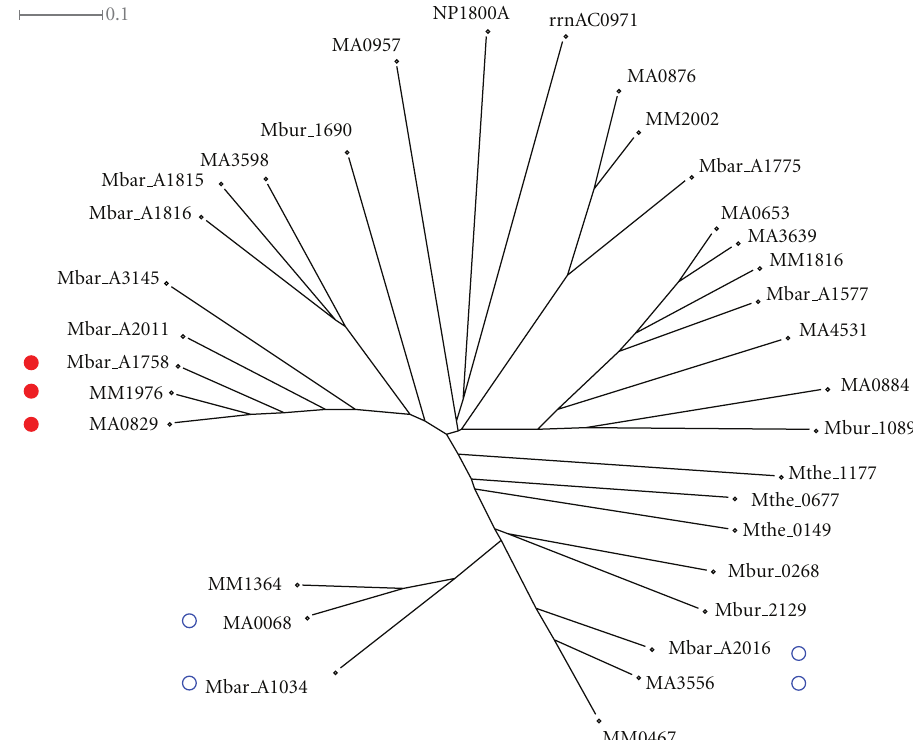
Figure 5: Phylogenetic tree of all DUF1608-containing genes in sequenced genomes of Methanosarcina and in other archaeal species. The organisms are: M. acetivorans , MA; M. mazei , MM; M. barkeri , Mbar A; M. burtonii , Mbur ; Methanosaeta thermophila PT., Mthe ; Haloarcula marismortui , rrnAC; Natronomonas pharaonis DSM2160, NP. The indicated major ( • ) and minor ( ◦ ) expressed S-layer proteins are described in the text.